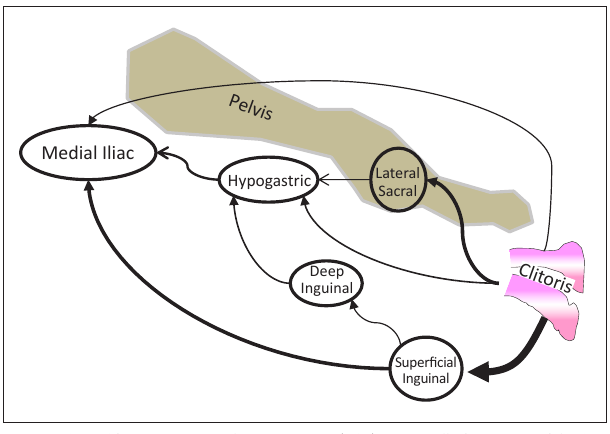
FIGURE 7: Schematic illustration of lymphatic drainage of the canine